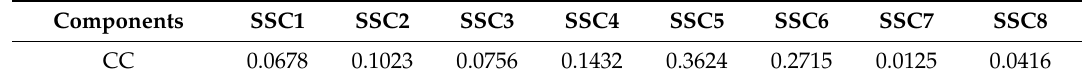
Table 5. Correlation coefficients of components.